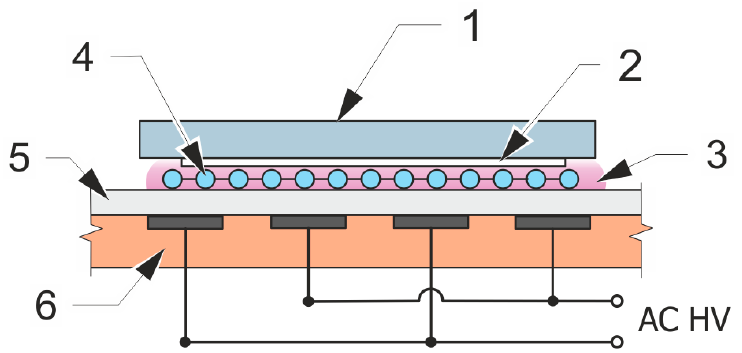
Figure 1. Scheme of plasma treatment set-up: (1) PP textile substrate; (2) treated PCL sample; (3) Ar discharge plasma; (4) spacer from PET mesh; (5) Al 2 O 3 electrode; (6) electrode cooling medium.